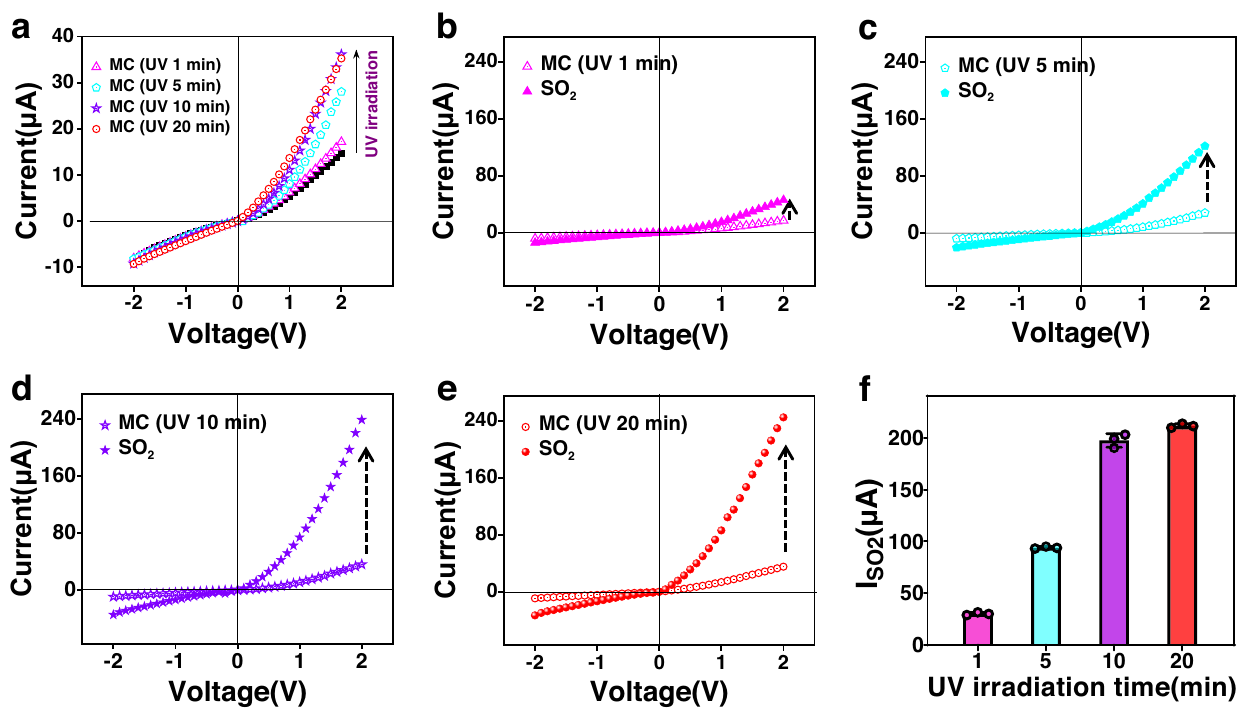
Fig. 4 | Effect of the photoactivation state on SO 2 response. a I − V curves of SP/ AAO nanochannels after different UV irradiation times. I − V curves of SP/AAO nanochannels treated with SO 2 after UV activation for ( b ) 1min, ( c ) 5min, ( d ) 10min, and ( e ) 20min. f Corresponding SO 2 response current (I SO denote the standard deviation from three different samples. MC (UV 1min):